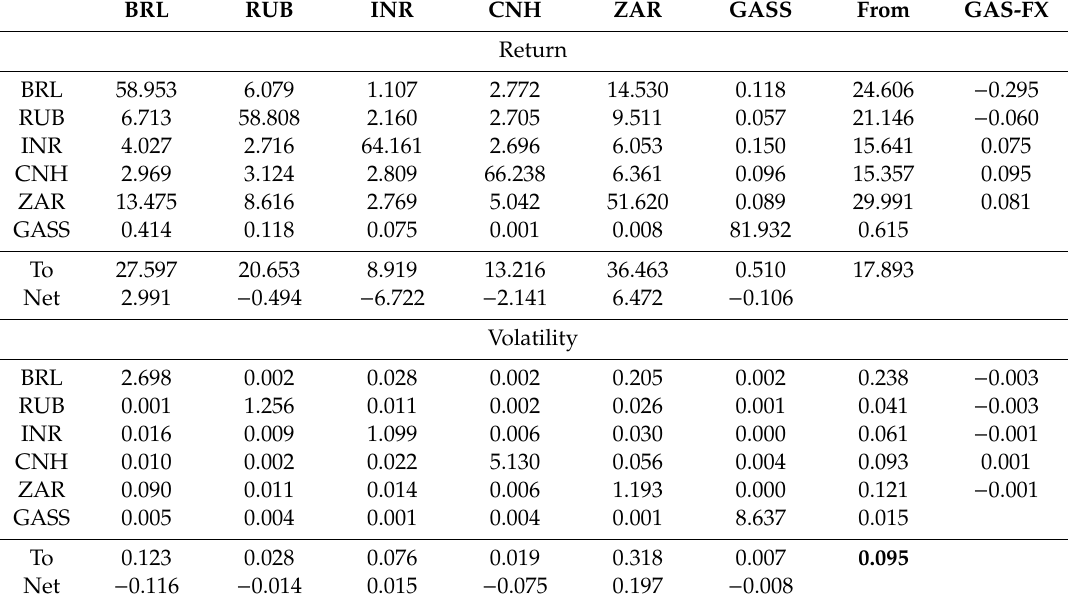
Table A3. Connectedness between the natural gas spot price and exchange rates in the frequency domain (short term).